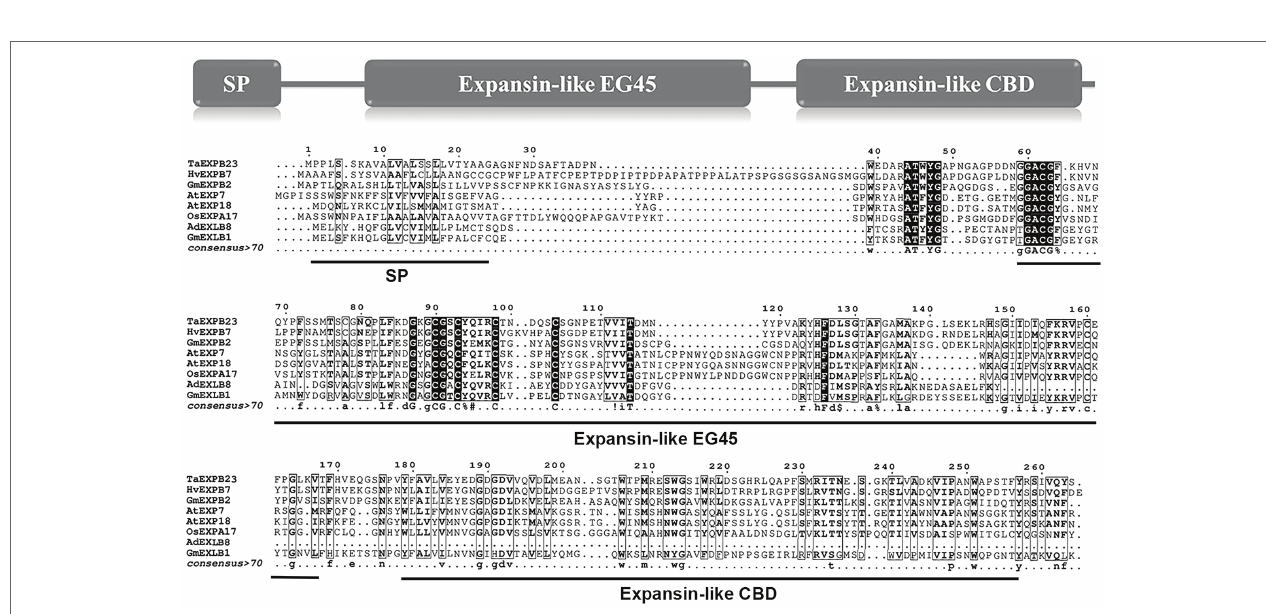
FIGURE 1 | Expression analysis of GmEXLBs. (A) Expression of GmEXLBs in different tissues/organs. RNA-seq data (Libault et al., 2010) are shown as a heat map. The color scheme used to represent the expression level is white/red: white indicates a low variation in expression and red indicates a high variation in expression. (B) Expression of GmEXLBs in roots. RNA-seq data from ZH15 roots treated with low phosphorus (LP) are shown as a heat map. The color scheme used to represent the expression level is green/red: green indicates a low variation in expression, and red indicates a high variation in expression.